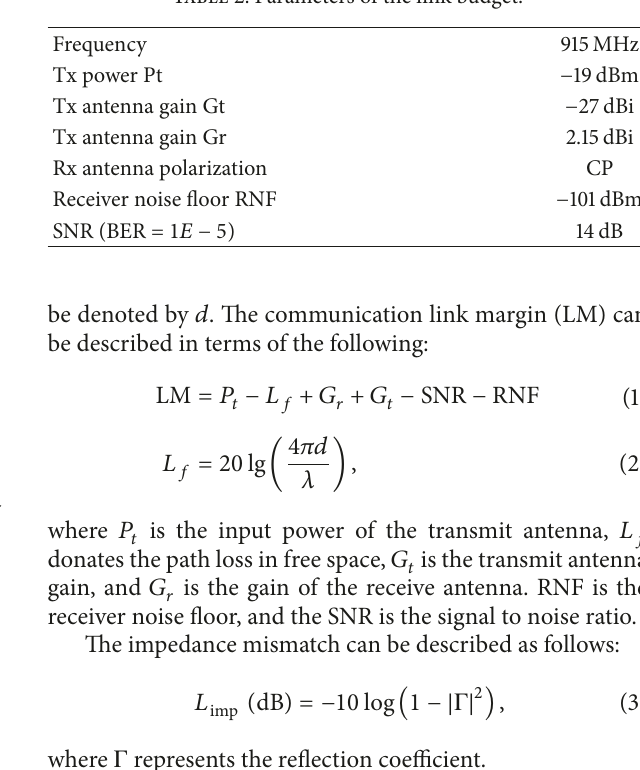
Table 2: Parameters of the link